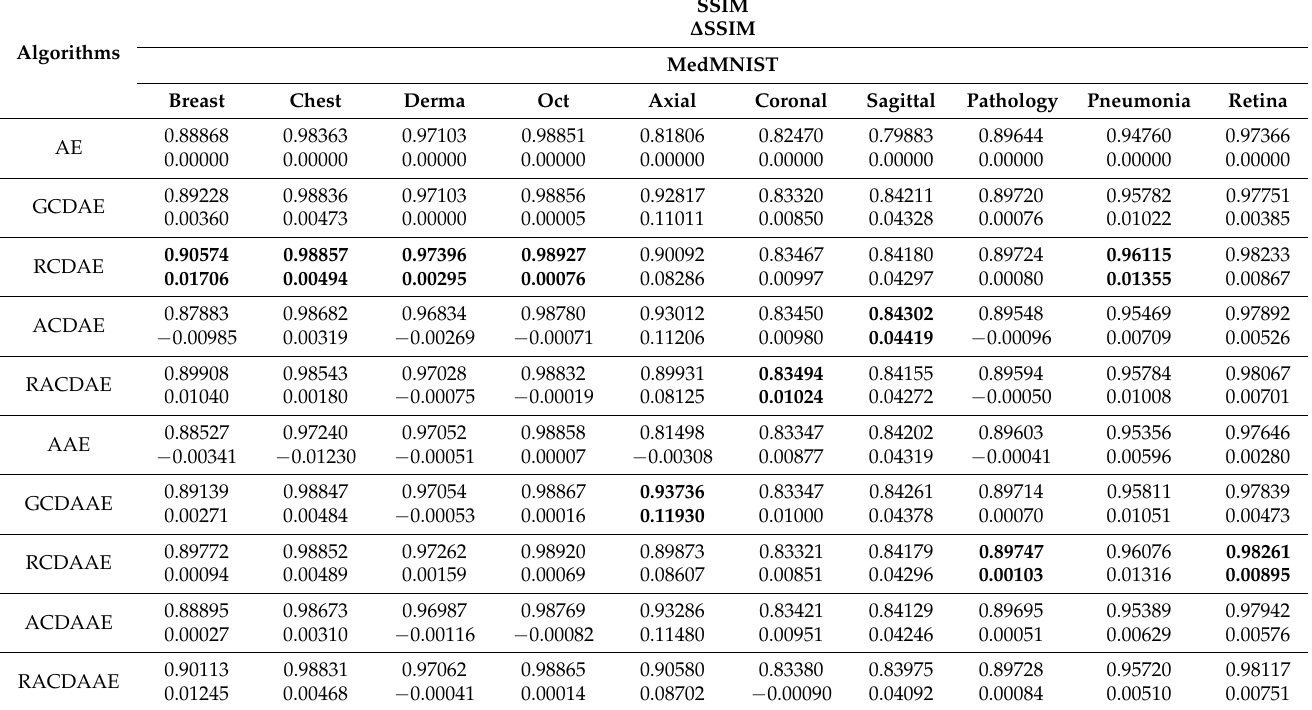
Table 8. Experimental results on the MMNIST data